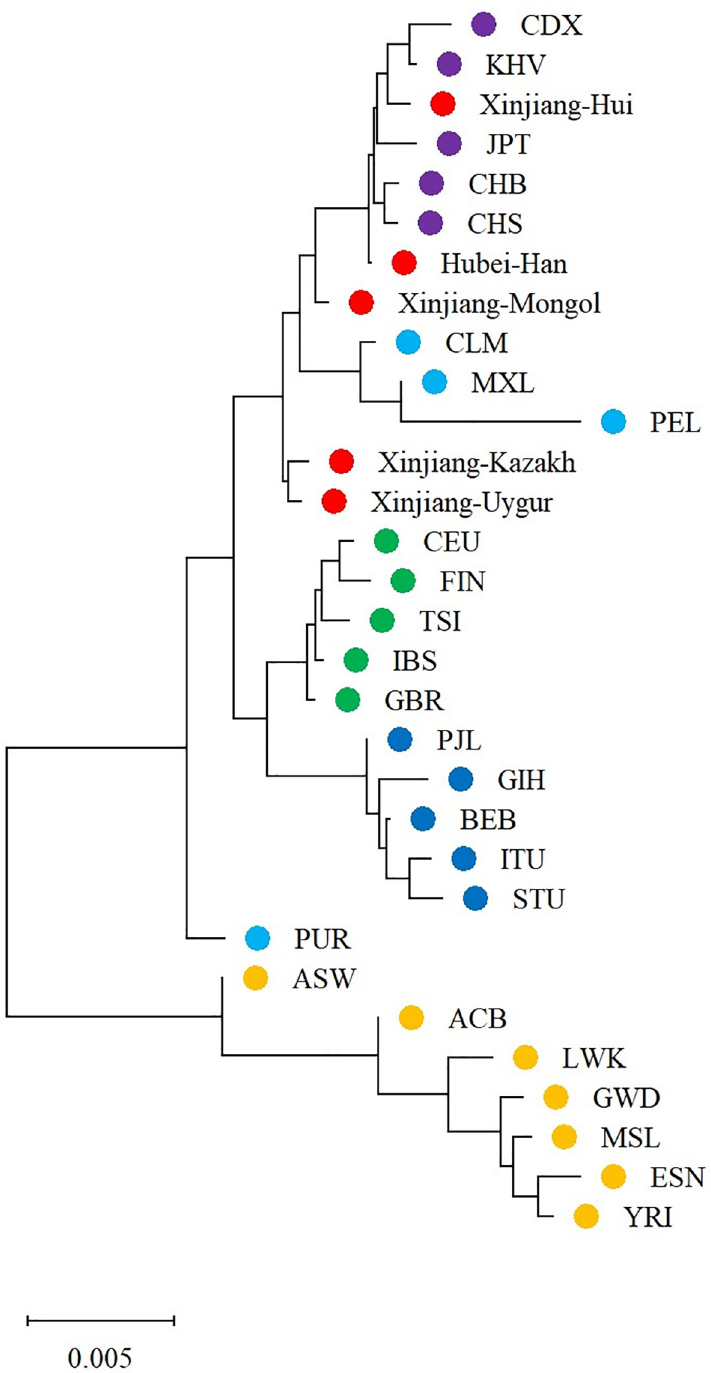
Fig 2. Phylogenetic tree (neighbor-joining tree) of the four studied Xinjiang populations, Hubei Han, and other 27 reference populations. Each dot denoted a population and different colors denoted different geographical regions: yellow for African, light blue for American, purple for East Asian, green for European, deep blue for South Asian, red for the four studied Xinjiang populations and Hubei Han.